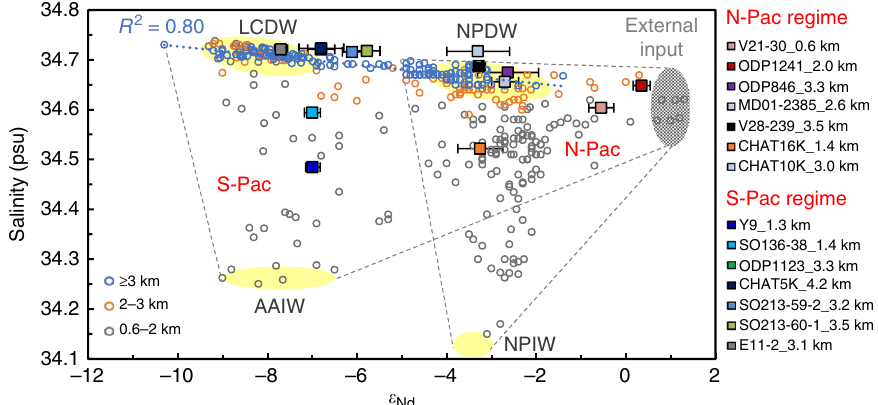
Fig. 4 Nd isotopic data for seawater and core-top foraminifera plotted against salinity in the Paci fi c Ocean (>600 m). Salinity data are estimated from World Ocean Altas 2009 using location and depth of seawater ε Nd measurements, and seawater ε Nd data are compiled from publications (ref. 14 and references within) and refs. 16,22,24,27,72 – 82 until March 2018, excluding the un fi ltered seawater of which the measured Nd isotope compositions are thought to be contaminated by particulates 83 . The yellow ovals show the characteristic ε Nd -salinity range of the water masses 12 . Note that NPDW is not formed from the sinking of surface water, instead its chemical property is acquired through the ageing of LCDW. The blue dotted trend line ( n = 136, R 2 = 0.8) exhibits a strong linear relationship between ε Nd and salinity for deep water below 3 km and points to the presence of an external source with high ε Nd compositions (grey oval). The core-top ε Nd (see legend for sediment cores with same colour coding in this paper and the data sources in Supplementary Table 1) are plotted against ambient seawater salinity. The scatter of the data points illustrates mixing between different water masses along with additional external input of radiogenic Nd isotopes, which fall into two regions labelled by ‘ S-Pac ’ and ‘ N-Pac ’ . Except CHAT10K, all the other cores deeper than 3 km reside nicely on the blue dotted ageing line, providing the basis for linking the spatial ε Nd gradients with deep water transit time. Error bars show the 2 σ external error of the ε Nd